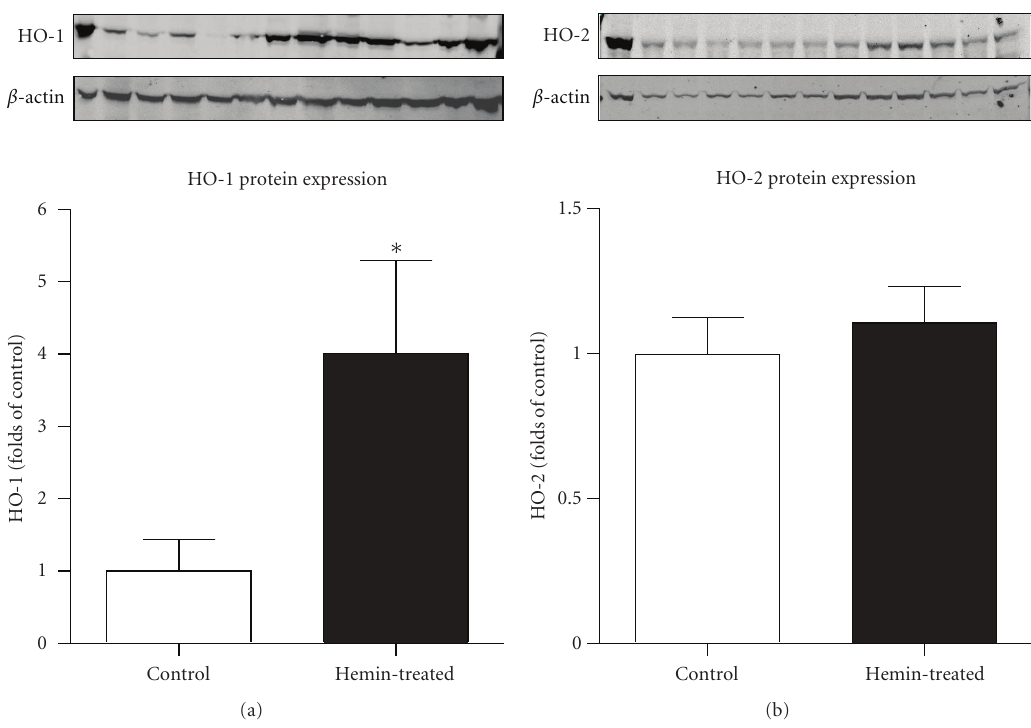
Figure 1: Western blot and densitometry analysis showing the e ff ect of treatment with Hemin (3mg/100 g body wt/day for 4 days) on renal HO-1 and HO-2 protein expression ( n = 6) compared to control rats ( n = 6). Results are normalized by β -actin and expressed as folds of control and presented as mean ± SE for each group, ∗ P < 0 . 05 versus Control.